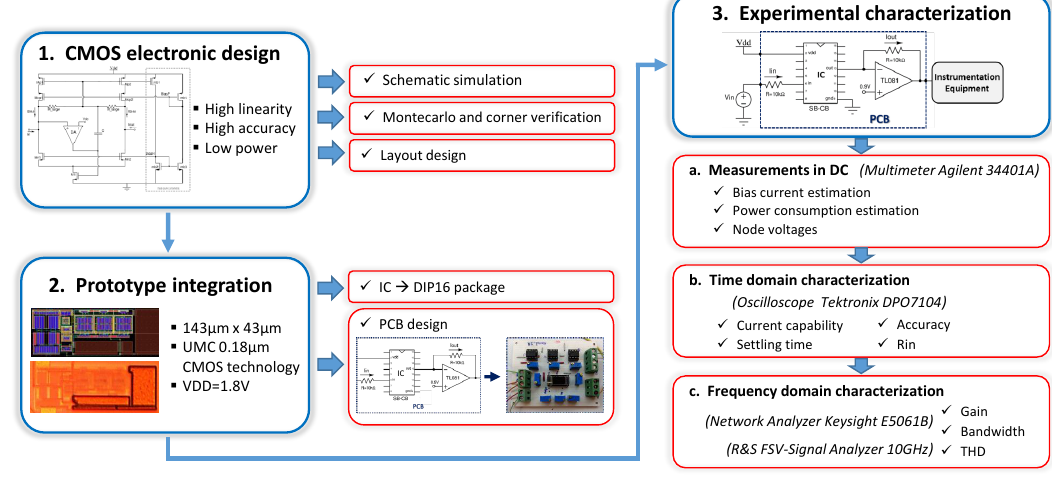
Figure 12. Experimental characterization block diagram.